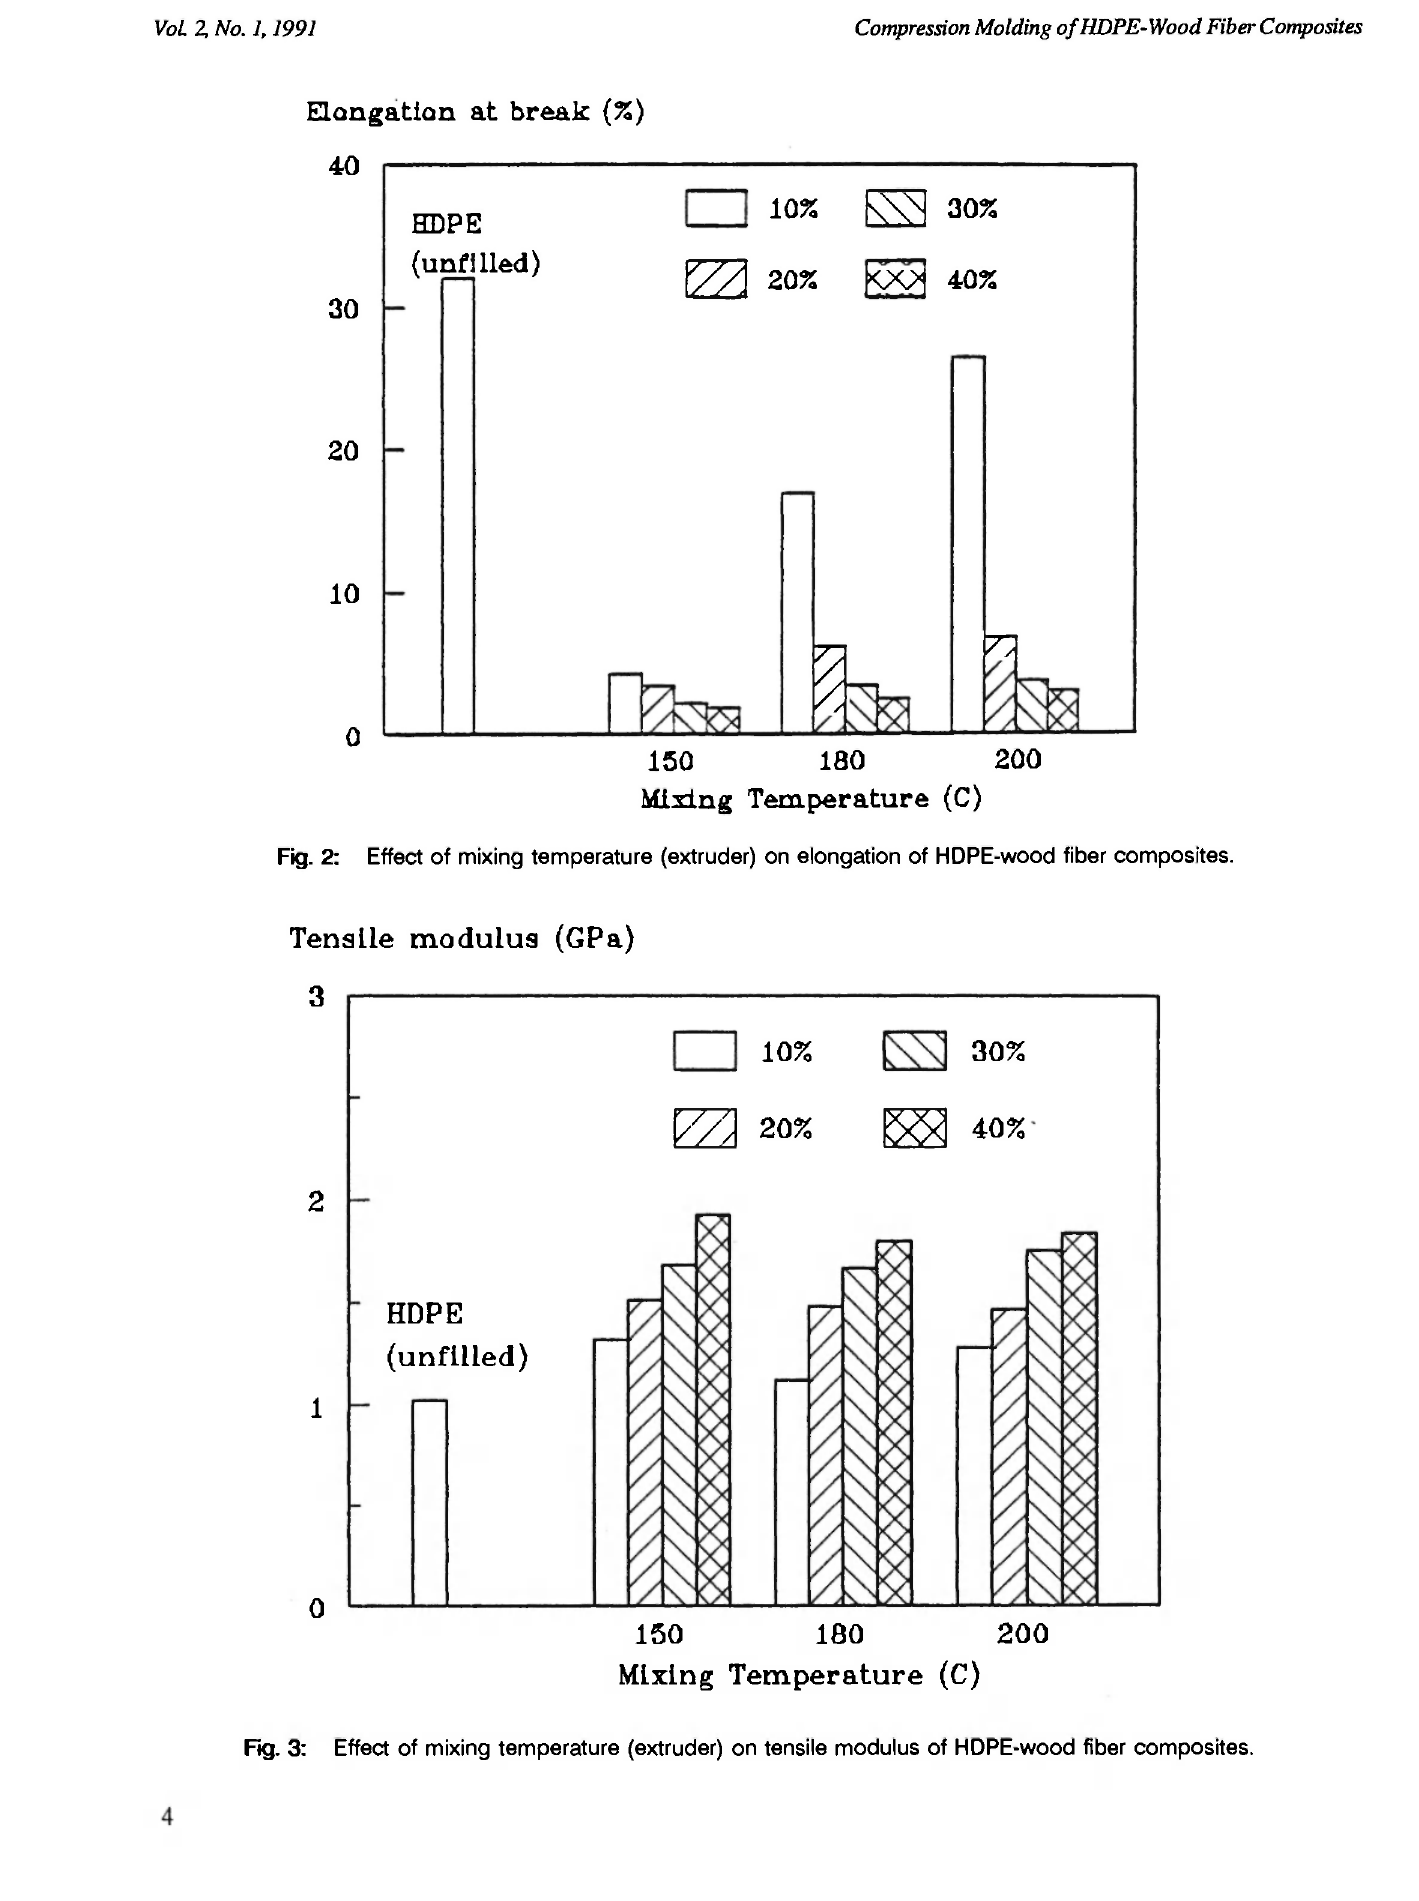
Fig. 3: Effect of mixing temperature (extruder) on tensile modulus of HDPE-wood fiber